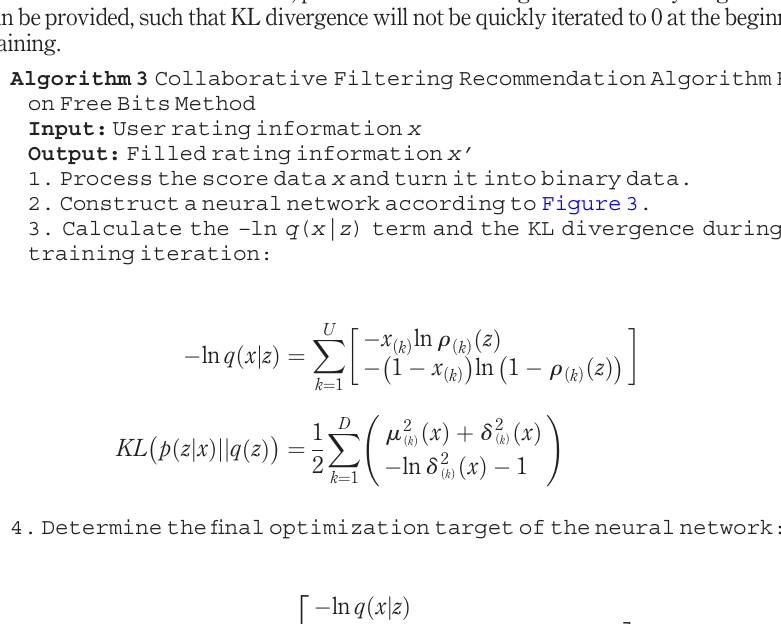
Algorithm 3 Collaborative Filtering Recommendation Algorithm